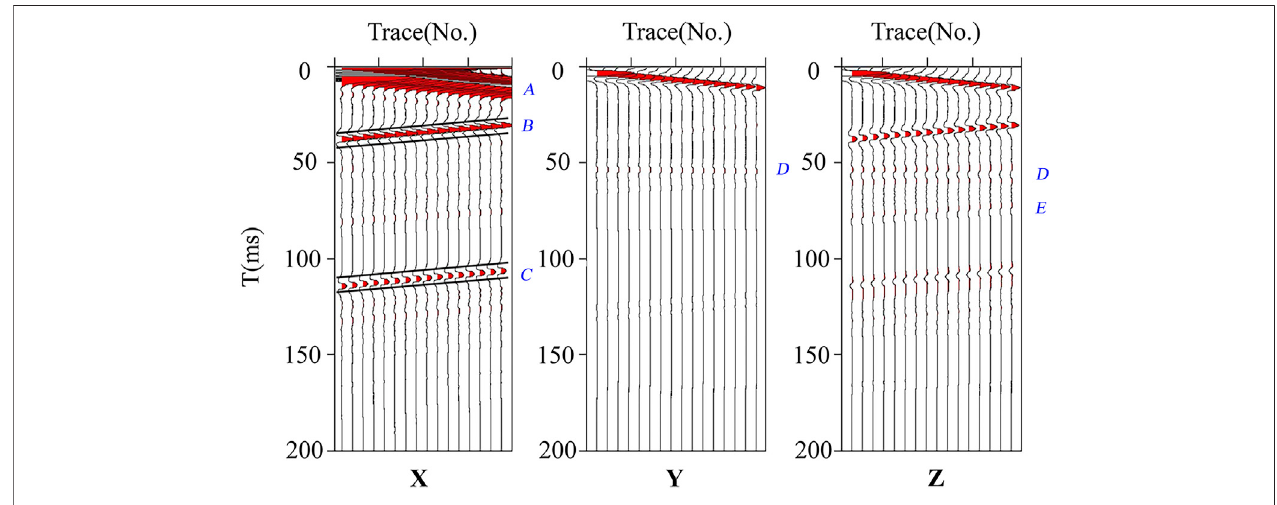
FIGURE 5 | Simulated three-component seismic records of advanced detetion.